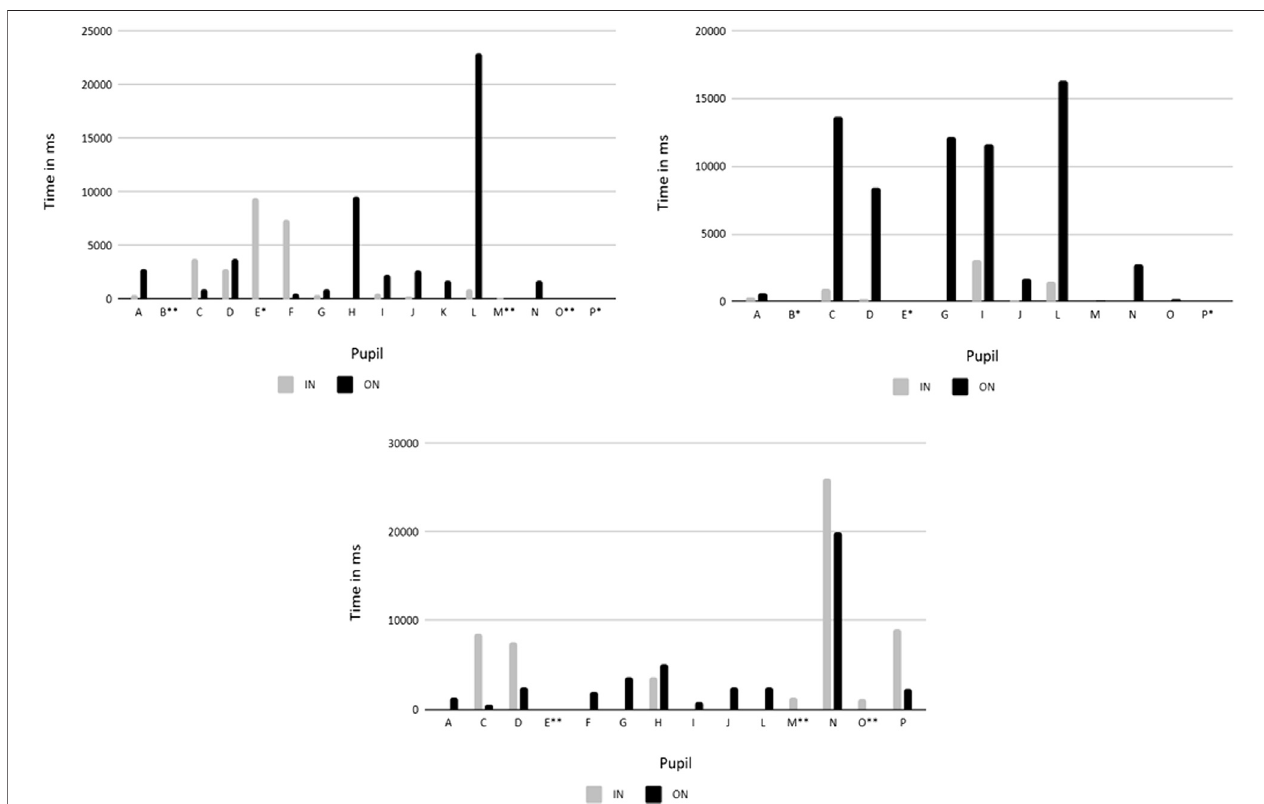
FIGURE 7 | Dwell times for individual pupils in IN and ON condition T3 (from left to right — T3_1, T3_3, T3_4). Two stars — pupil invisible in ON condition; one star — pupil poorly or rarely visible or almost invisible in ON